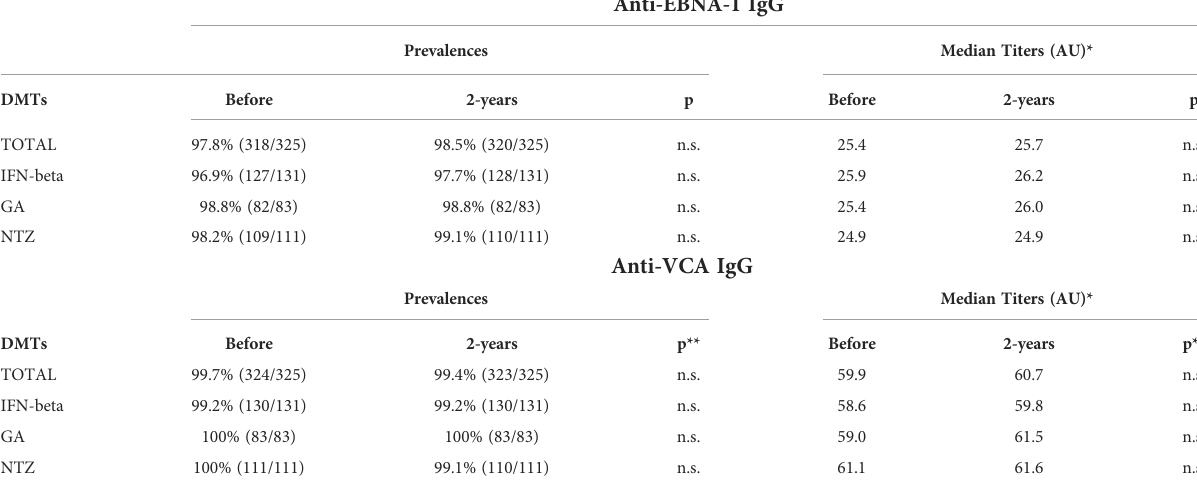
TABLE 5 Prevalences and median titers of the anti-EBNA-1 and VCA IgG antibodies before and after 2-years of treatment with the different